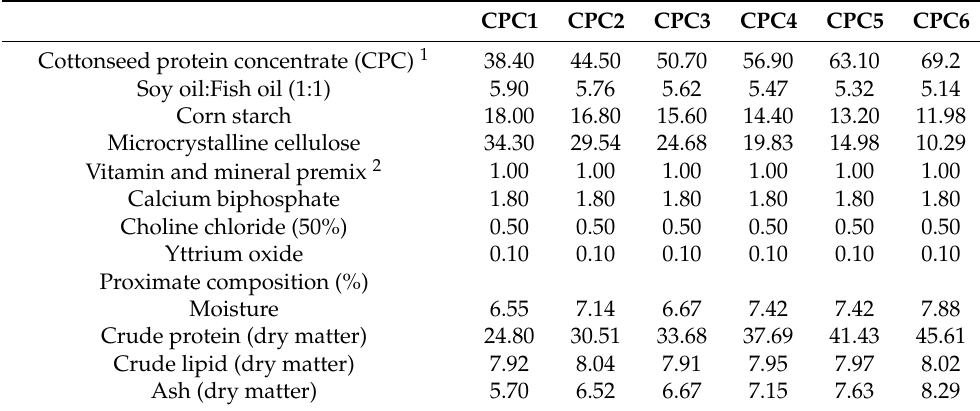
Table 1. Ingredients and proximate composition of the experimental diets with different protein levels (expressed as % dry